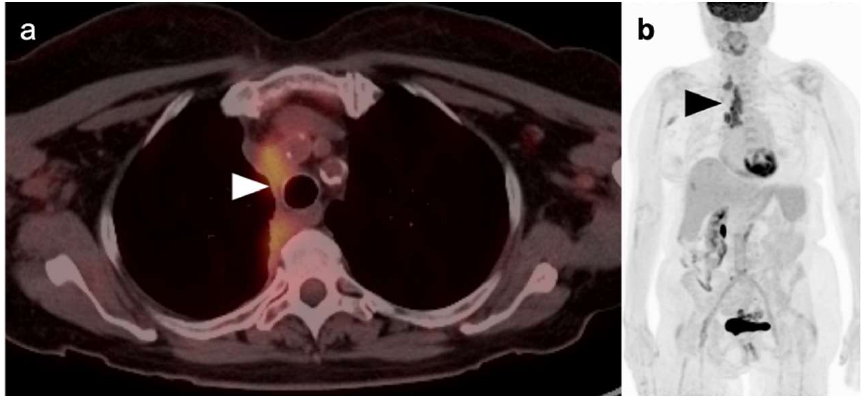
Figure 11. “Limited disease” small cell lung cancer. ( a ) Fused axial PET/CT image from a 73-year- old patient with biopsy-proven small cell lung cancer demonstrates an infiltrative hypermetabolic mass along the right paramediastinum ( white arrowhead ); ( b ) Whole-body FDG PET MIP image, shows that the hypermetabolic mass is extends superiorly to the high mediastinum and right medial supraclavicular region ( black arrowhead ). No other abnormal foci of uptake are identified. This patient is staged as “limited disease small cell lung cancer” (LD-SCLC).